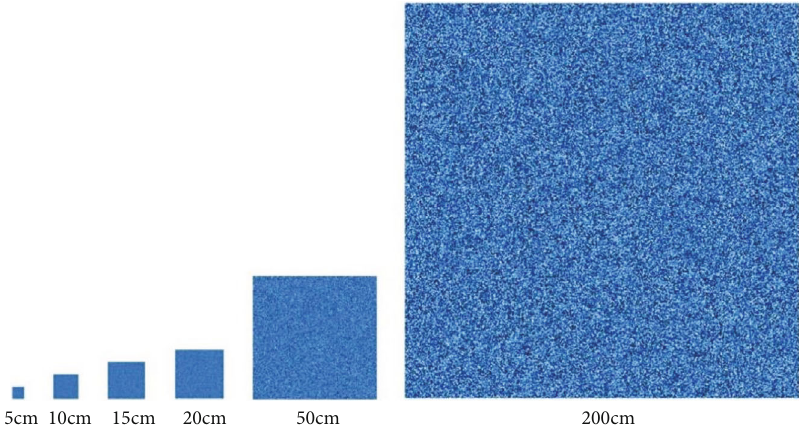
Figure 1: Numerical models of di ff erent sizes. Table 1: Mesoscopic parameters of the numerical